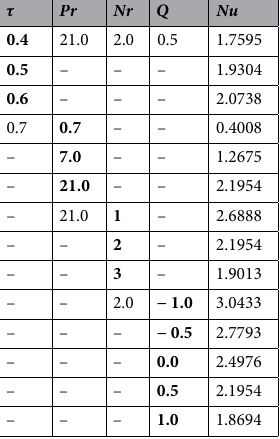
Table 1. Variation of Nusselt number for different values of parameters. Bold values are used to specify the variation of a particular